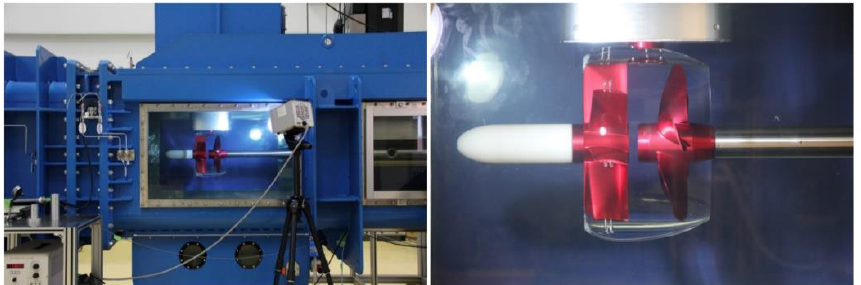
Figure 2. Experiment research on pump-jets by the propeller dynamometer in a cavitation tunnel [17].